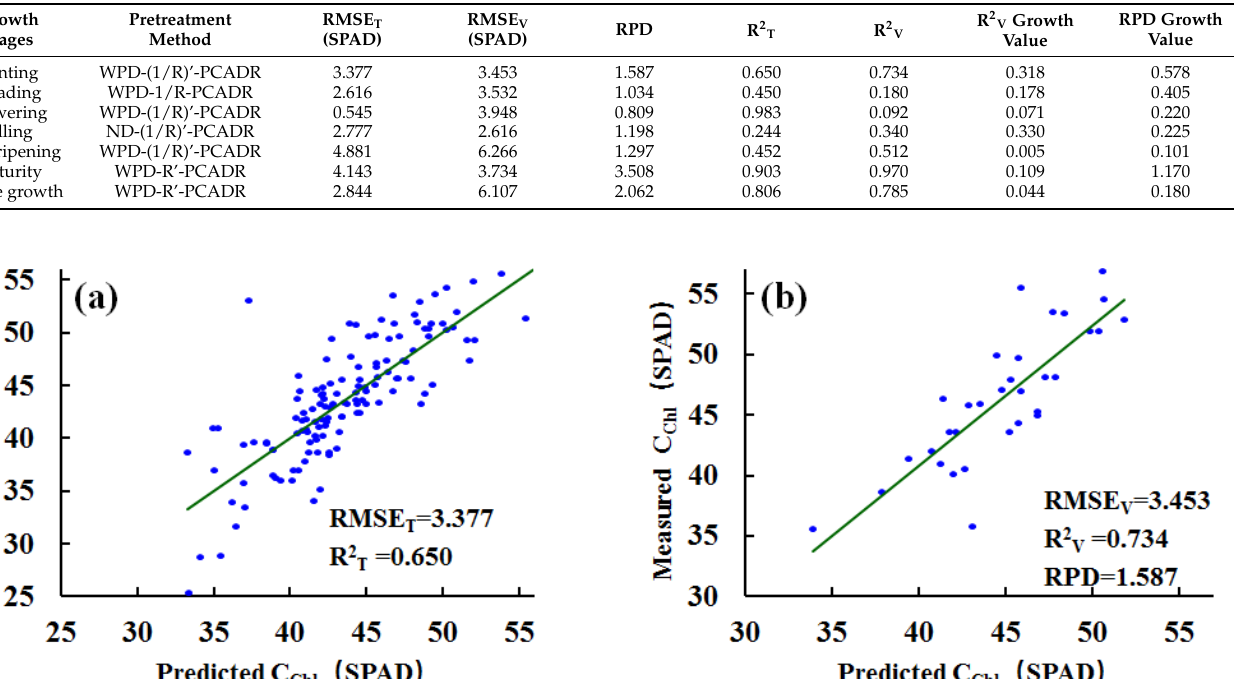
Figure 11. The estimated results of SPAD value for ( a ) training set and ( b ) validation set based on pretreatment WPD-1/R-PCADR at heading stage. Figure 12. The estimated results of SPAD value for ( a ) training set and ( b ) validation set based on pretreatment WPD-(1/R)’-PCADR at flowering stage.